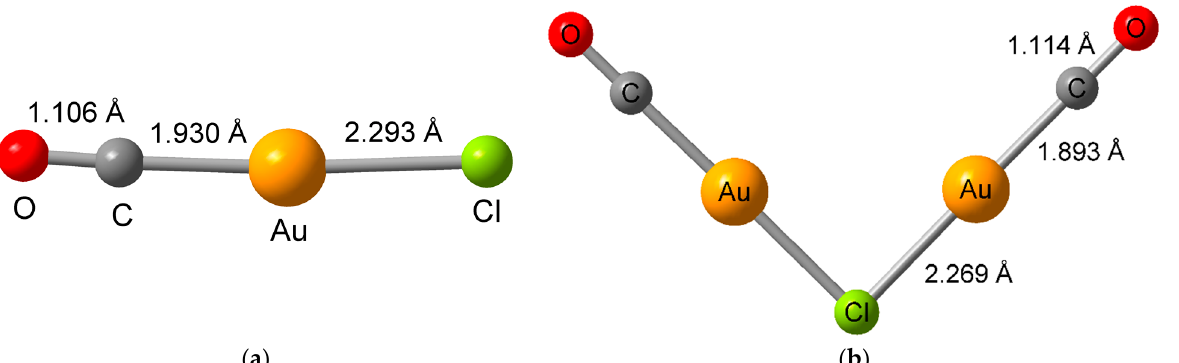
Figure 1. Structure of ( a ) the (OC)Au···Cl moiety in the solid-state adduct [(OC)-Au···ClAl(OR F ) 3 ] and ( b ) the µ-chloridodicarbonyldigold(I) cation in [Au 2 (CO) 2 Cl] + [Al(OR F ) 4 ] − (R F = C(CF 3 ) 3 ) [46]. The overall length in (OC)Au···Cl from O to Cl is ~5.3 Å to which the van der Waals (vdW) radii of O (1.52 Å) and Cl (1.75 Å) would have to be added for the full length of OC-Au-Cl. For the cross- section along the molecular axis twice the vdW radius of Cl can be taken since the vdW radius of Au (1.66 Å) is smaller